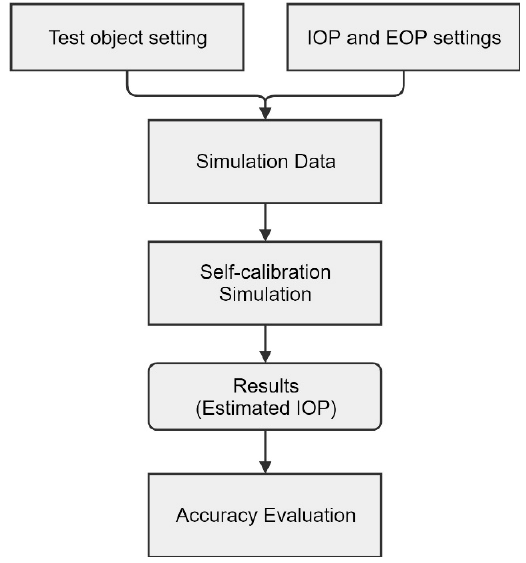
Figure 3. Flow chart of self-calibration simulation.